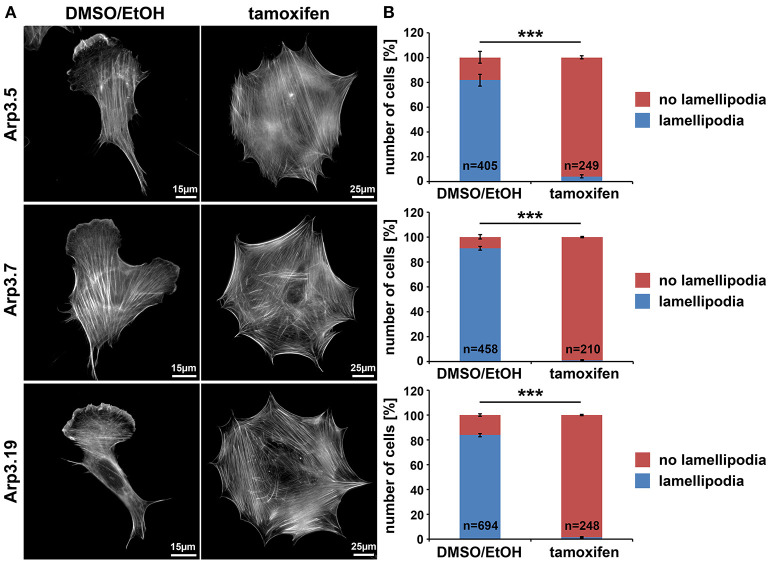
Arp3-depleted MEFs are devoid of lamellipodia. (A) Phalloidin-stained examples of distinct Actr3fl/fl clones (Arp3.5, Arp3.7, and Arp3.19) stably expressing tamoxifen-inducible Cre recombinase, with (tamoxifen) or without (DMSO/EtOH) tamoxifen induction (96 h) causing disruption of the Actr3 gene. Tamoxifen treatment causes near to complete elimination of lamellipodia in representative cells shown. Scale bars as indicated in individual panels. Note the strong increase of spread cell area upon Arp3 disruption. (B) Quantification of lamellipodia formation efficiency upon treatments as shown in A. Data are arithmetic means and standard errors of means from three independent experiments; n = total number of cells analyzed; data were statistically compared using two-sided, two-sample t-test (***p < 0.001).